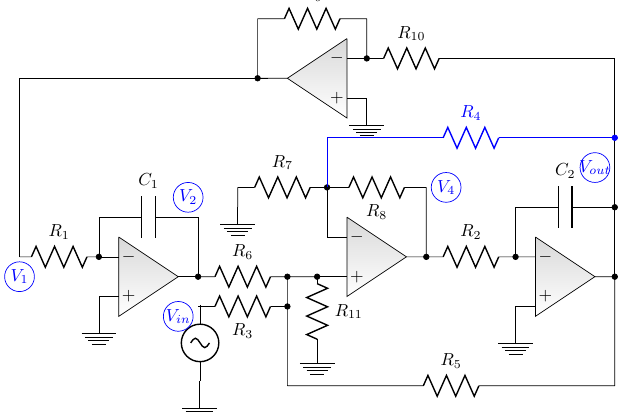
Figure 3. Schematic diagram of the biquadratic bandpass filter implemented with opamps